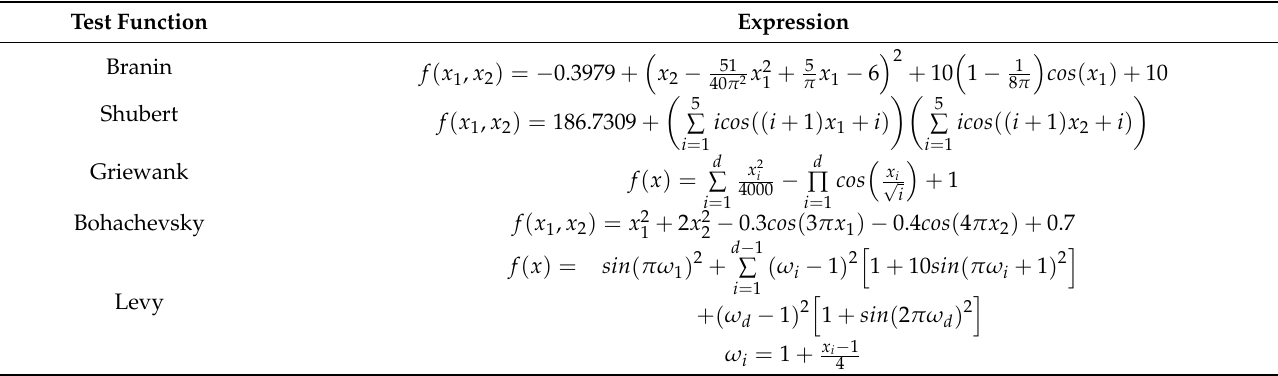
Table 1. Information of the test functions.